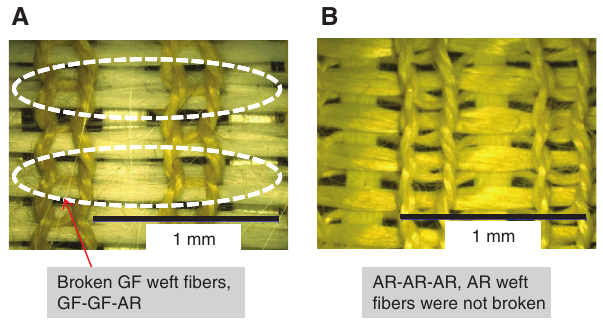
Figure 10 Photographs of BWK-reinforcement fabrics. (A) GF-GF-AR (some of GF weft fibers were broken). (B) AR-AR-AR (AR weft fibers were not broken).